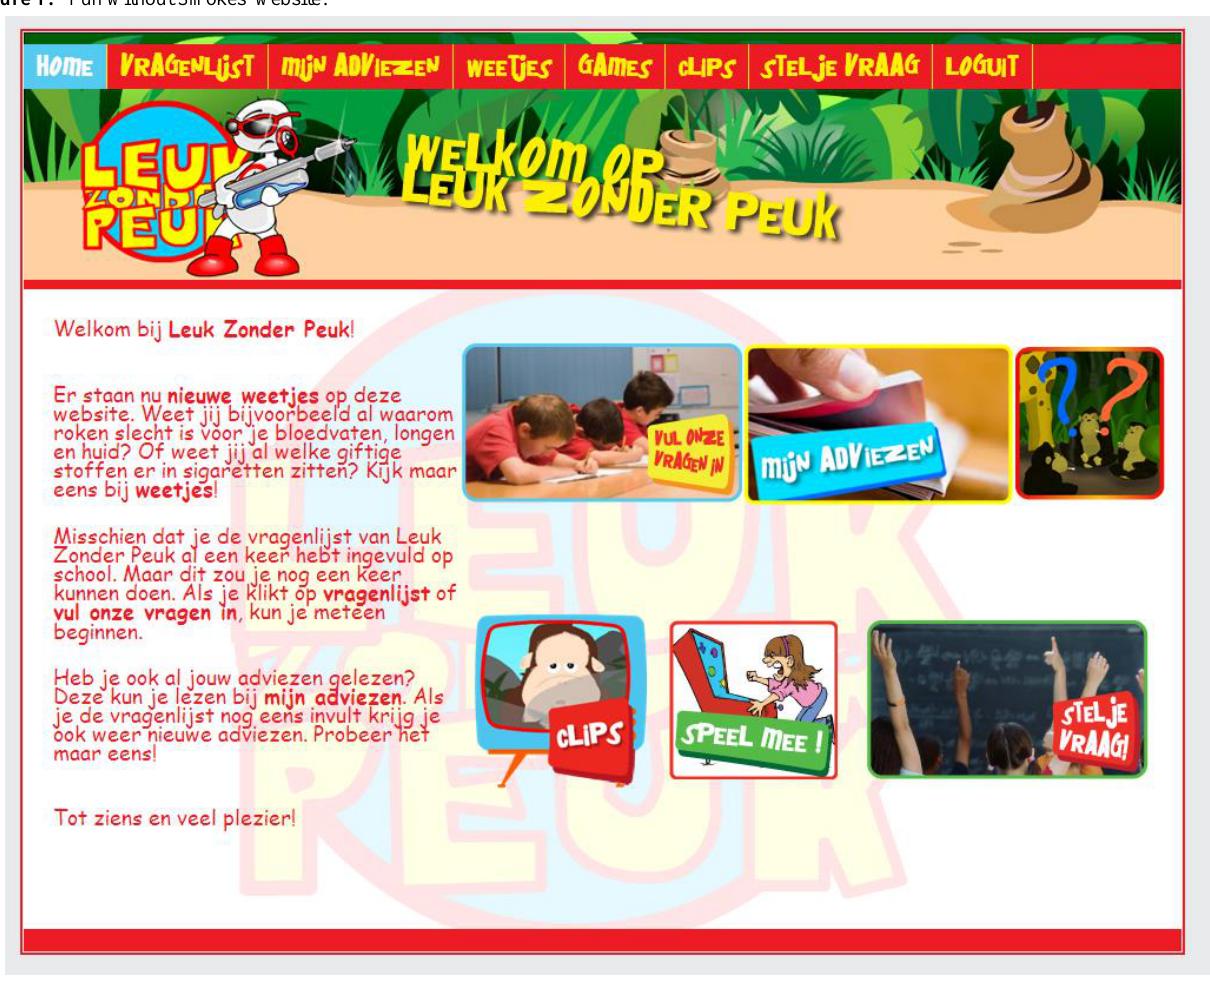
Figure 1. ‘Fun without